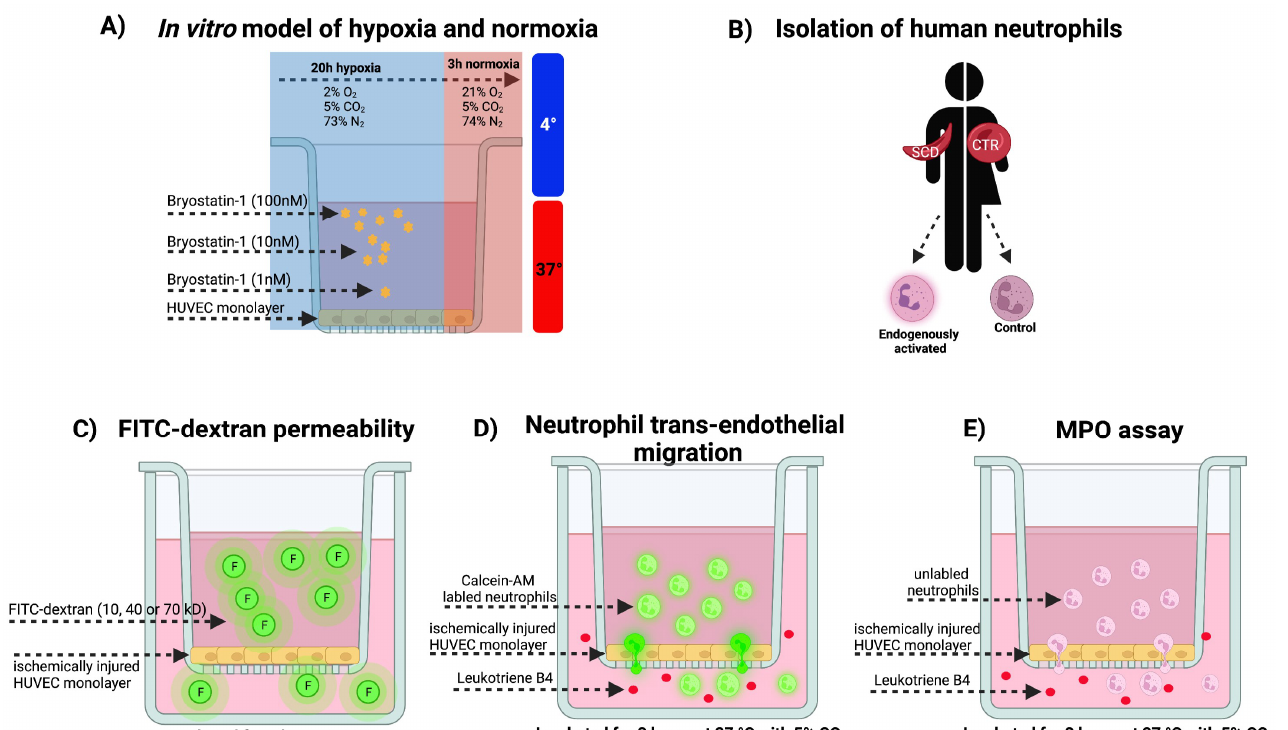
Figure 1. Experimental outline. ( A ) An in vitro model of hypoxia and normoxia was used. For this, transwell systems were equipped with human umbilical vein endothelial cell (HUVEC) monolayers and treated with varying concentrations of Bryostatin-1 (1, 10, 100 nM) or a vehicle control. Next, HUVECs were incubated for 20 h at 37 ◦ under hypoxic (2% O 2 , 5% CO 2 , and 73% N 2 ) conditions (mimicking the ischemic phase in the ischemia reperfusion sequence), followed by 3 h under normoxic (21% O 2 , 5% CO 2 , and 74% N 2 ) conditions (mimicking the early reperfusion phase in the ischemia reperfusion sequence). Control cells were kept under normoxic conditions. Some experiments were conducted under hypothermia (4 ◦ ); ( B ) Human neutrophils were obtained from healthy volunteers (CTR) or sickle cell patients (SCD), a disease known for its endogenous neutrophil activation; ( C ) To study endothelial barrier function, control and ischemically injured HUVEC monolayers were kept in transwell systems, and FITC-dextran (either 10, 40, or 70 kD) was added to the upper chamber. After 1 h incubation, FITC-dextran concentrations in the lower chambers were measured using a plate reader; ( D ) To study neutrophil trans-endothelial migration, control and ischemically injured HUVEC monolayers were kept in transwell systems, calcein-AM labeled neutrophils were added to the upper chamber, and the chemoattractant leukotriene B 4 (or vehicle control) was added to the lower chamber. After 3 h incubation, calcein fluorescence intensity was measured, and the migration index was calculated by dividing the number of neutrophils migrating toward LTB 4 by the number of cells migrating to the vehicle. Subsets of experiments were conducted with neutrophils from SCD patients or after pre-treatment with tumor necrosis factor alpha; ( E ) To study neutrophil activation, control and ischemically injured HUVEC monolayers were kept in transwell systems, and unlabeled neutrophils were added to the upper chamber, and the chemoattractant leukotriene B 4 (or vehicle control) was added to the lower chamber. After 3 h incubation, MPO activity was measured in the transmigrated neutrophils (this figure was created with BioRender.com, accessed on 25 February